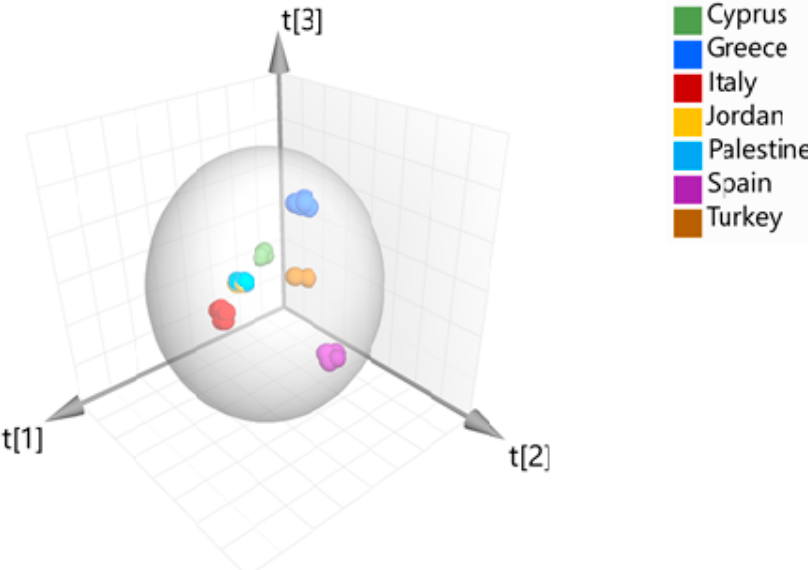
Figure 3. O rthogonal partial least square-discriminant analysis model (3D plot) ( N = 76, R 2 X (cum) = 0.59, Q 2 (cum) = 0.60), discriminating the groups of carobs from Cyprus, Italy, Spain, Greece and Turkey.